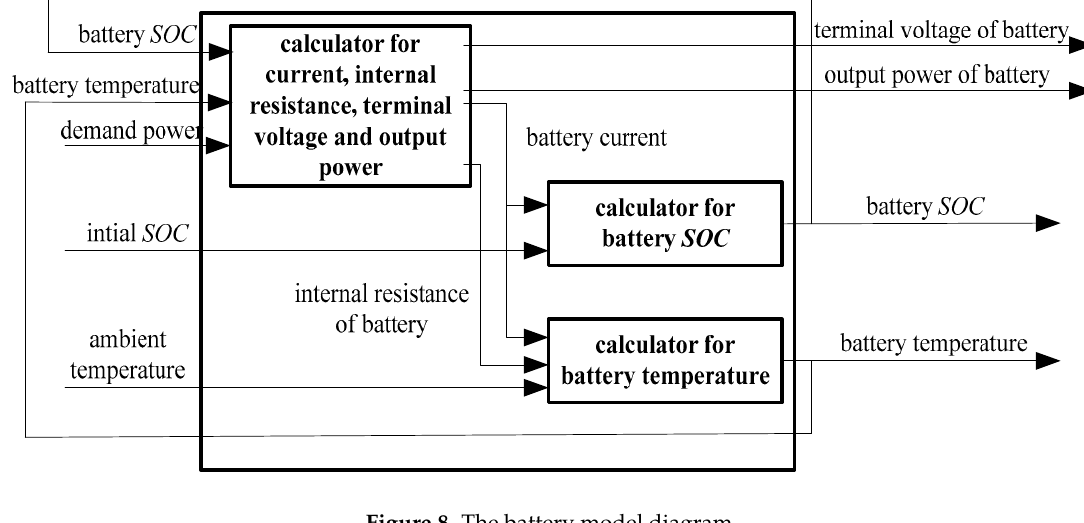
Figure 8. The battery model diagram. Table 8. Main characteristic parameters of the battery.